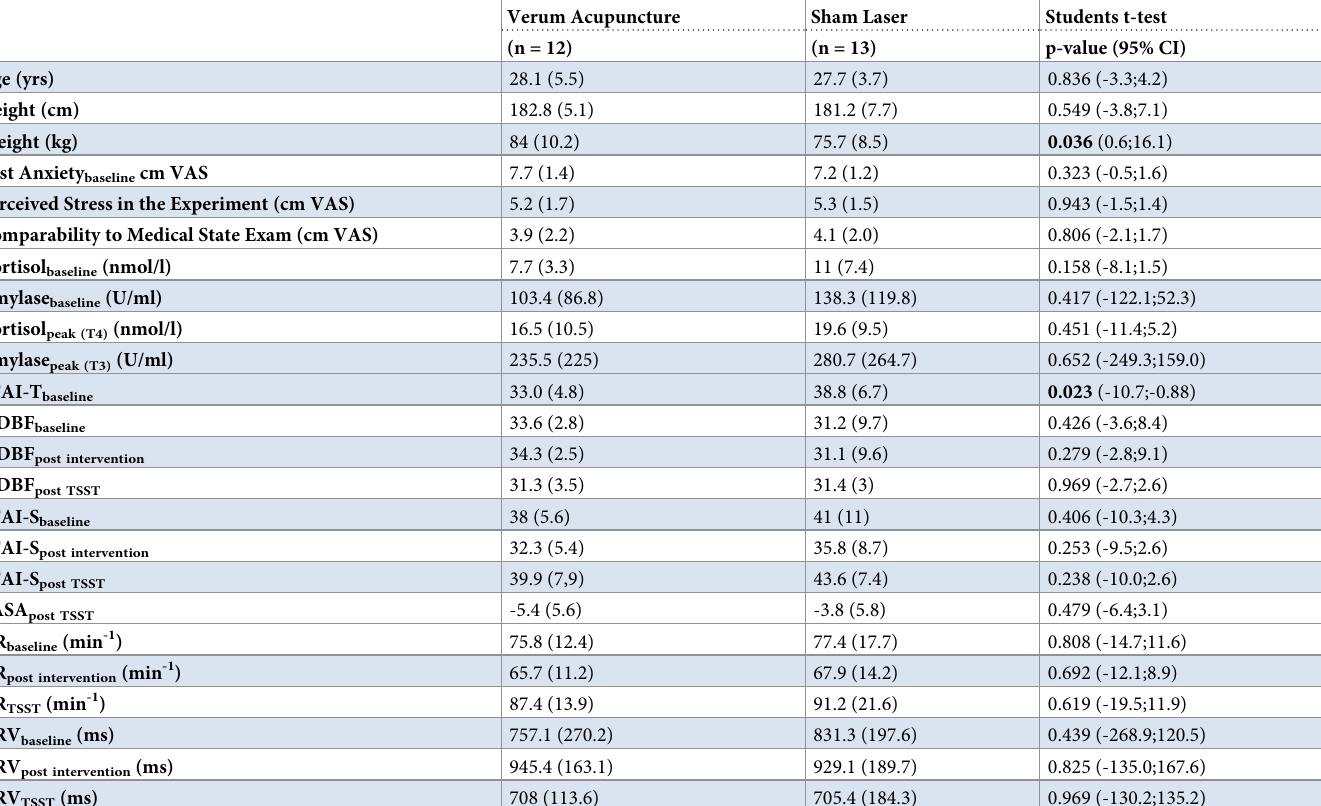
Table 1. Participants’ characteristics. Data is expressed as means (SD), with paired Students’ t-test indicating statistical differences between the Sham and the Verum Group. 95% CI = confidence interval, STAI state trait anxiety inventory (with the subscores–T trait and–S state), MDBF multidimensional mood questionnaire, PASA pri- mary appraisal secondary appraisal, HR heart rate HRV heart rate